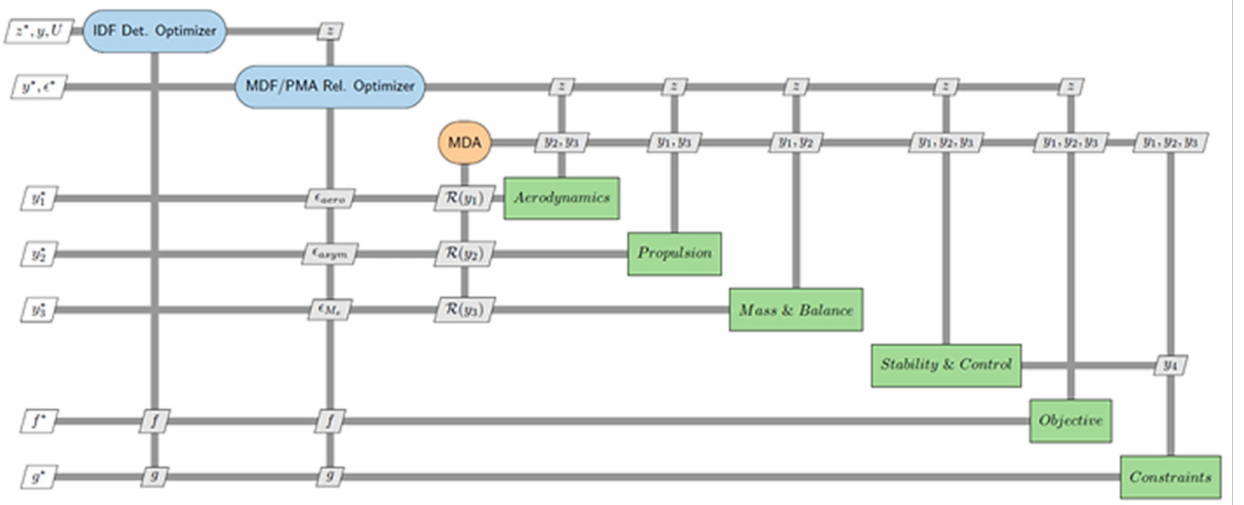
Figure 5. The block diagram of the MDO process to size the empennage of the aircraft. Reprinted from